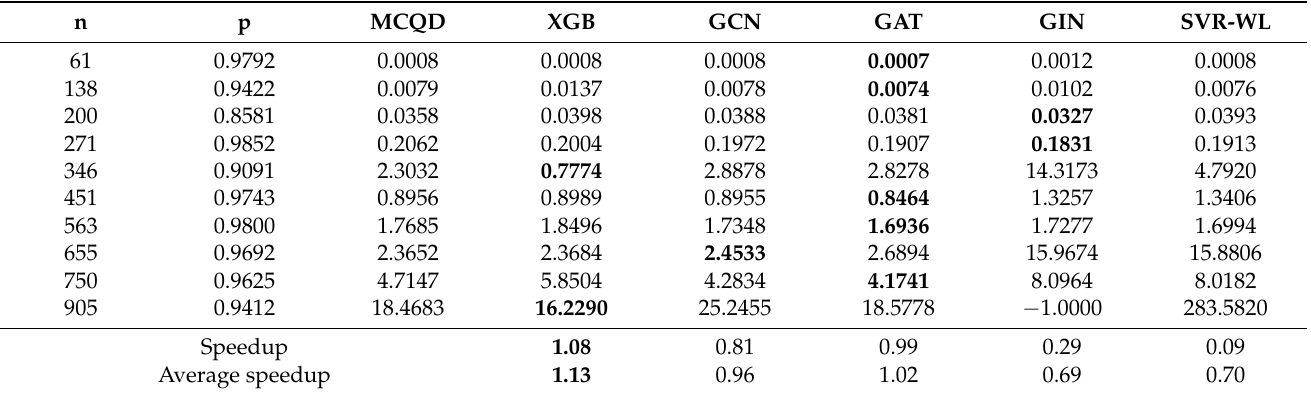
Table 4. Times that algorithms need to find maximum clique for each graph from test set of small product graphs. Best times are in